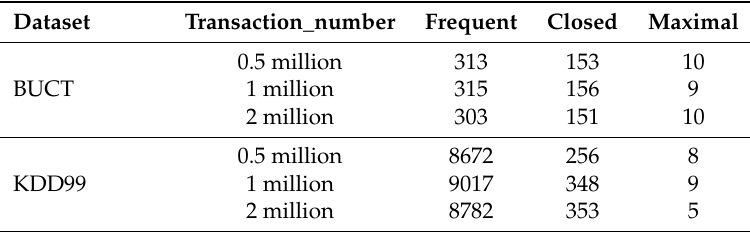
Table 4. The number of